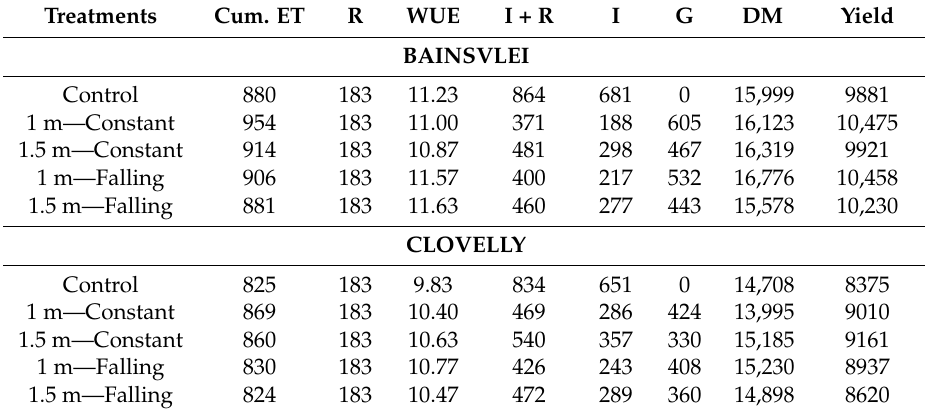
Table 1. Collective data for wheat